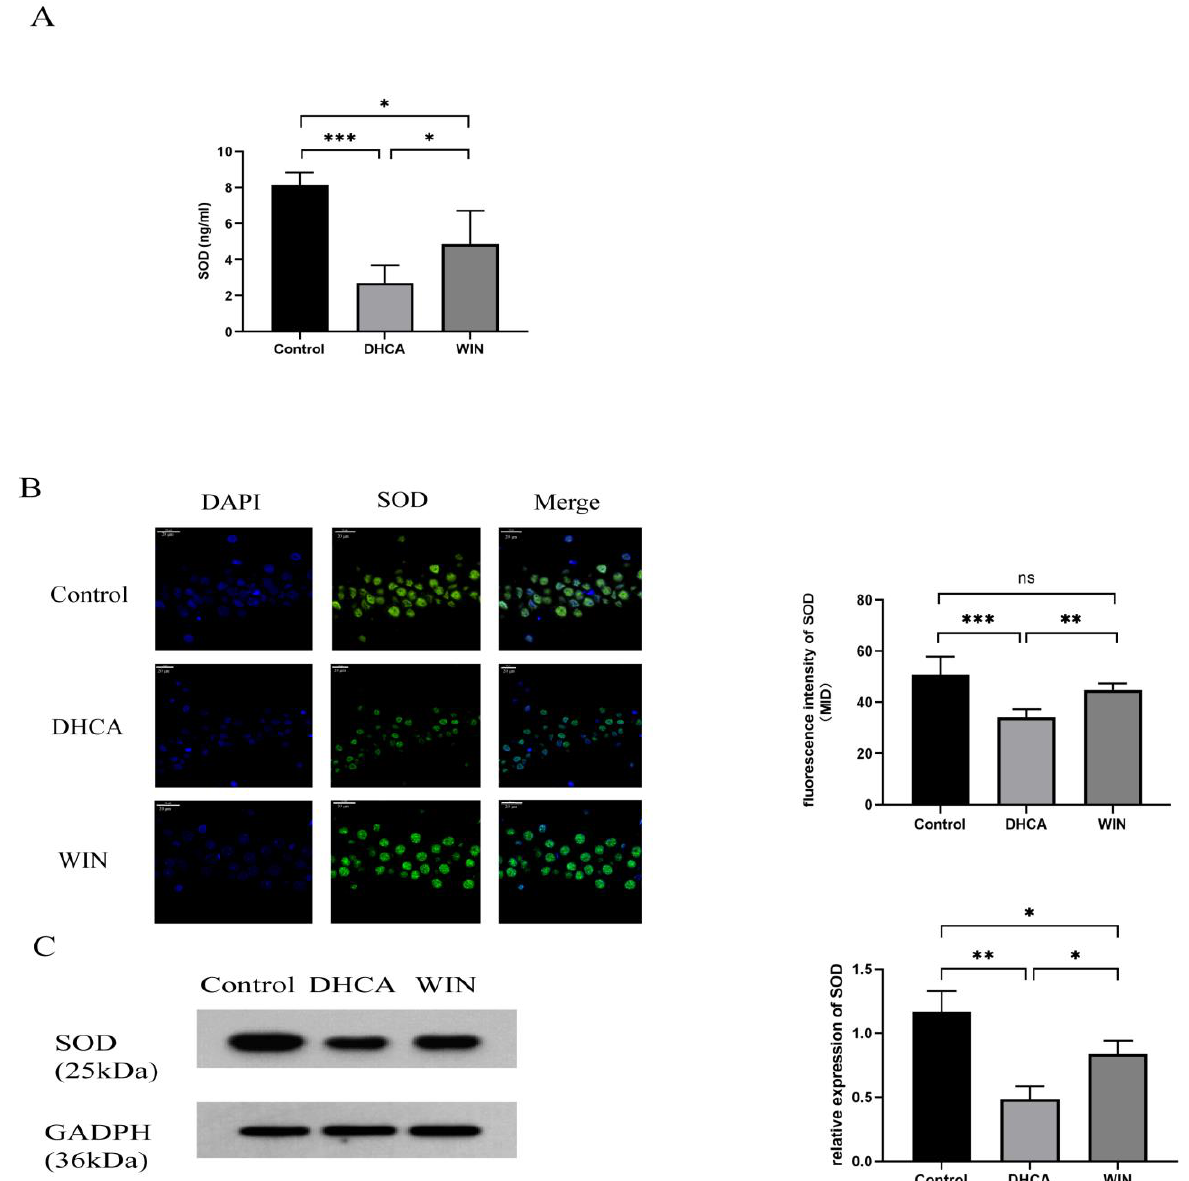
Figure 4. WIN55, 212-2 inhibits the decrease in SOD in rats that underwent DHCA. ( A ) Comparison of the plasma SOD levels among control, DHCA, and WIN55, 212-2-treated DHCA groups. n = 6. ( B ) Immunofluorescence staining showing the differences among groups in SOD content in the hippocampal tissue of the rats. Representative images: magnification 900 × , bar graph: n = 5. The scale bar is 20 µ m. ( C ) Western blot analysis of SOD expression in different groups. n = 3. * p <